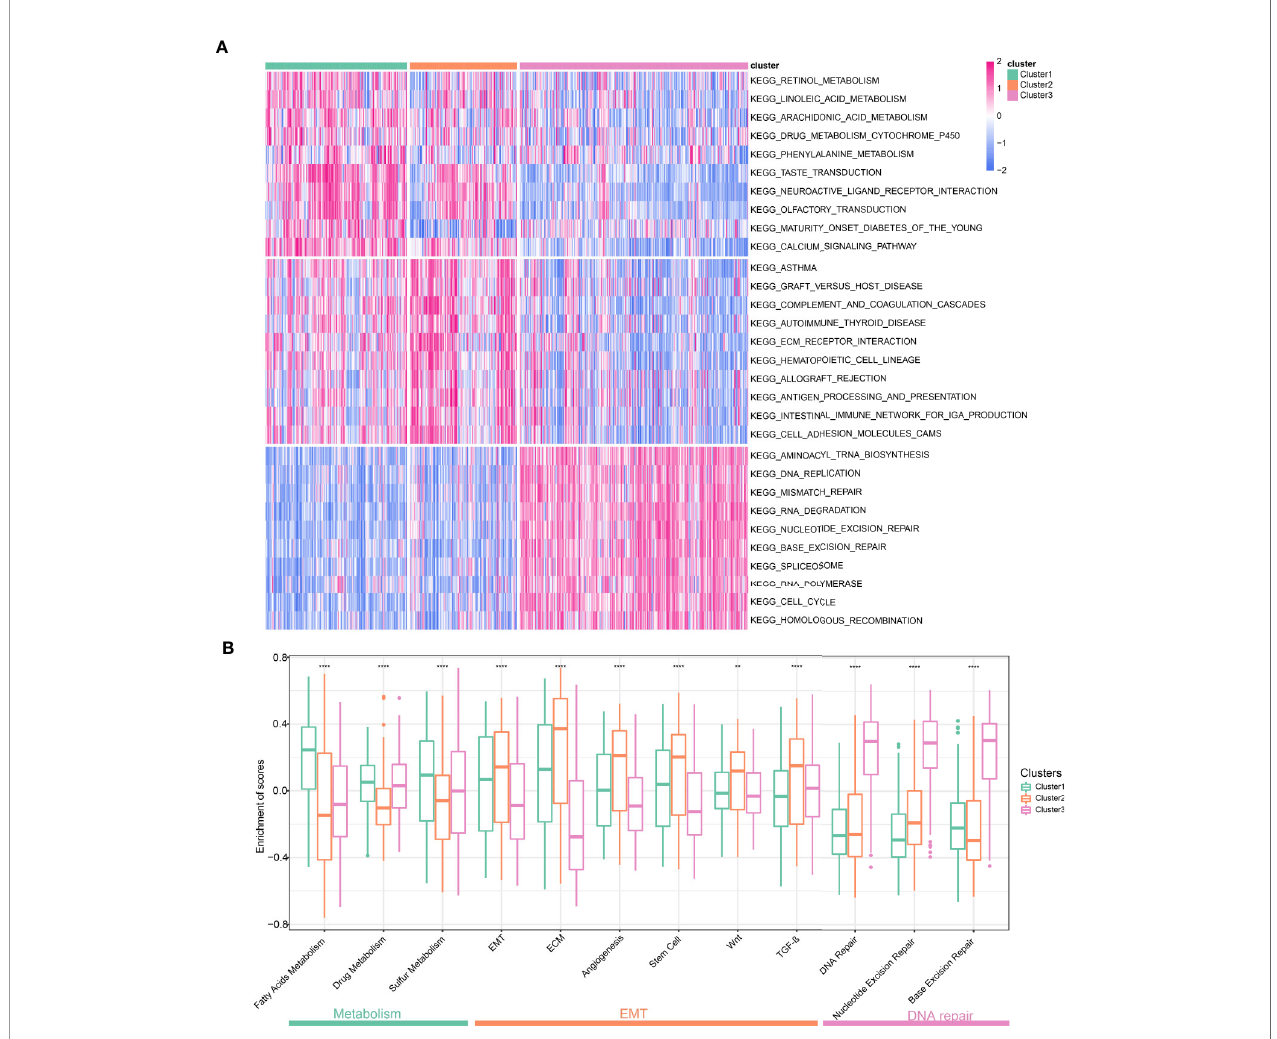
FIGURE 5 | Biological pathways and processes enriched in different Clusters. (A) Heatmap of different pathways among the three clusters. Each cluster exhibit 10 of the most distinctive KEGG pathways. (B) Comparison representative pathways and its enrichment scores in different